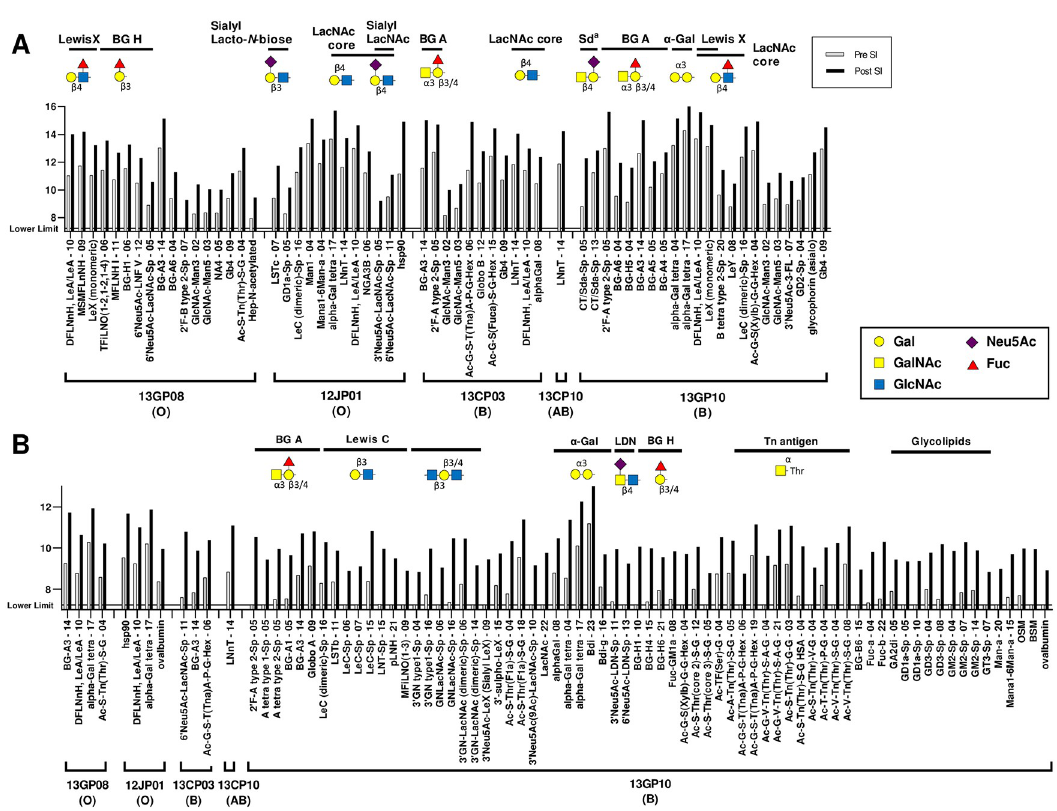
Fig 3. The list of carbohydrates that were significantly elicited in the posttransplant sera (the changes of normalized signal intensity � 1.5; na ï ve sera, gray; posttransplant sera, black). (A) IgM repertoire. (B) IgG repertoire. The number after the abbreviation indicates the average number of carbohydrates per molecule of albumin. The blood type of a monkey is noted in brackets.